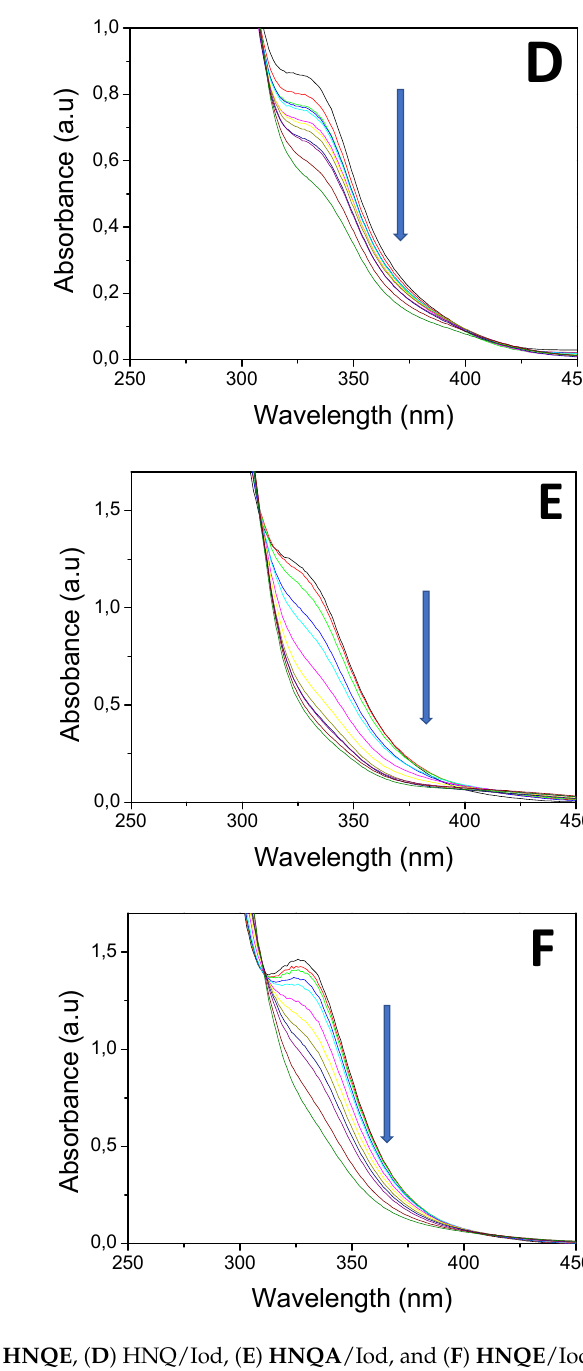
Figure 1. Steady-state photolysis of ( A ) HNQ, ( B ) HNQA , ( C ) HNQE , ( D ) HNQ/Iod, ( E ) HNQA /Iod, and ( F ) HNQE /Iod upon LED@385 nm exposure (44 mW/cm 2 ). UV − vis spectra were recorded at different irradiation times under air after 420 s of irradiation. [HNQ] = 2.1 × 10 − 4 M, [ HNQA ] = [ HNQE ] = 5 × 10 − 4 M, [Iod] = 1.7 × 10 − 3 M.